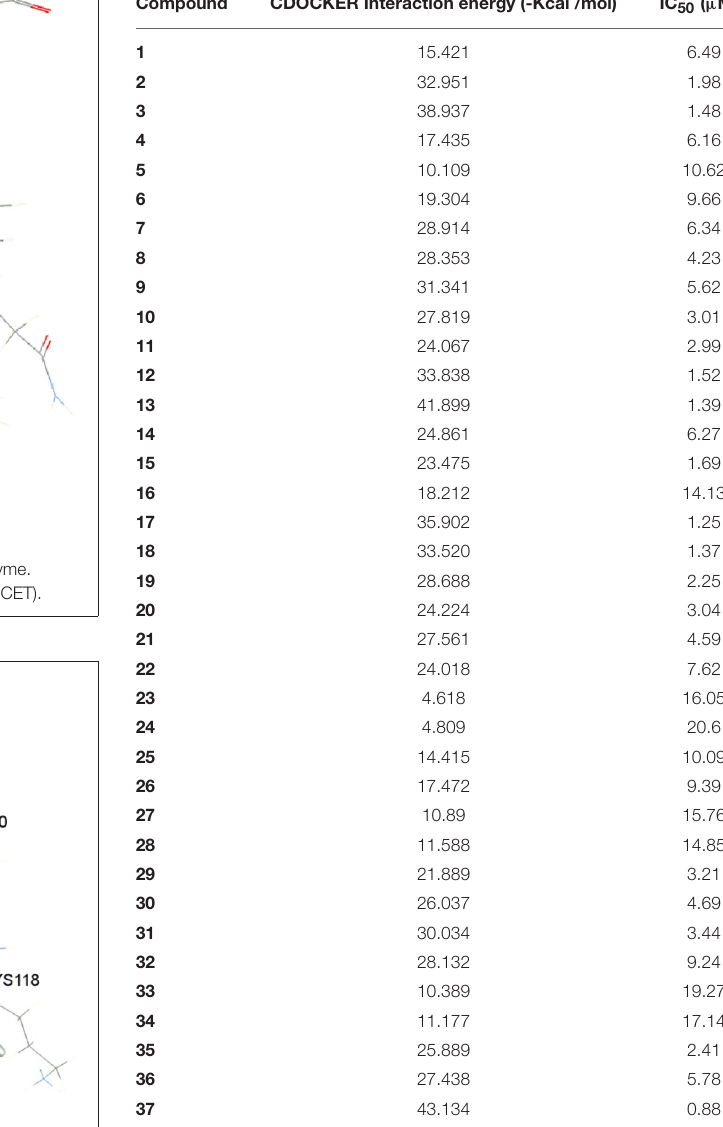
FIGURE 3 | Binding of compound 37 in active site of enzyme LDH.